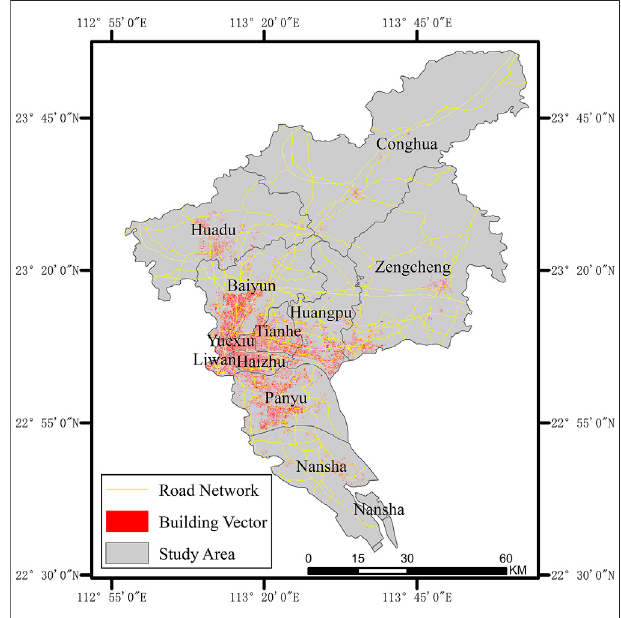
FIGURE 1 | Study Area (The study area is Guangzhou China, including 11districtssuchasHaizhudistrict,TianhedistrictandYuexiudistrict.Thedata involved in the fi gure includes road network data and building vector data of